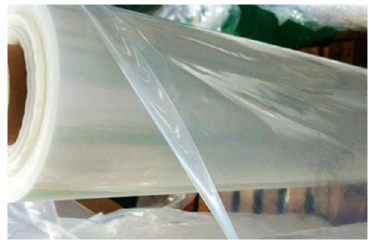
Figure 6. Folds in the canvas.